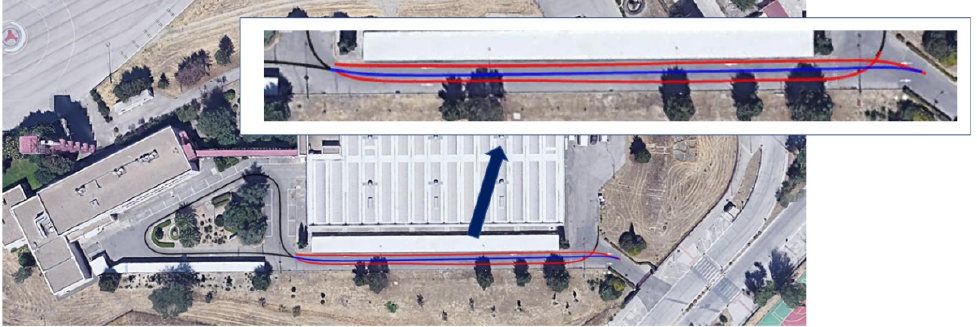
Figure 7. Vehicle trajectories in the parking lot (blue: S1; red: S2; black: common).